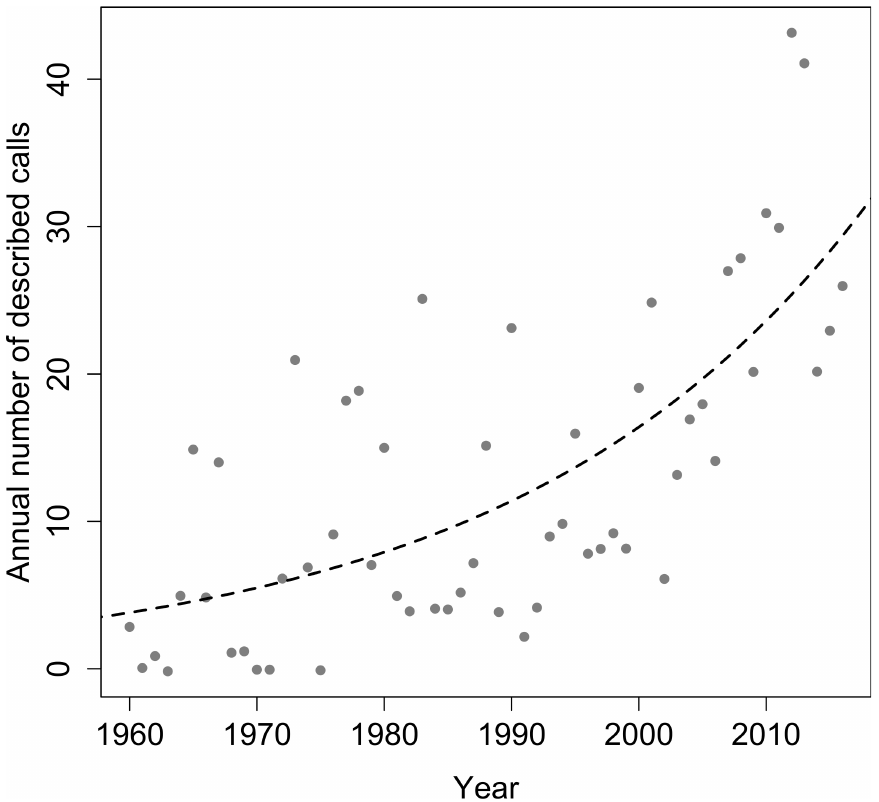
Fig 1. Evolution in the descriptions of the advertisement calls of Brazilian anurans between 1960 and 2016. Regression function and line fitting the annual number of new described calls over the last six decades.